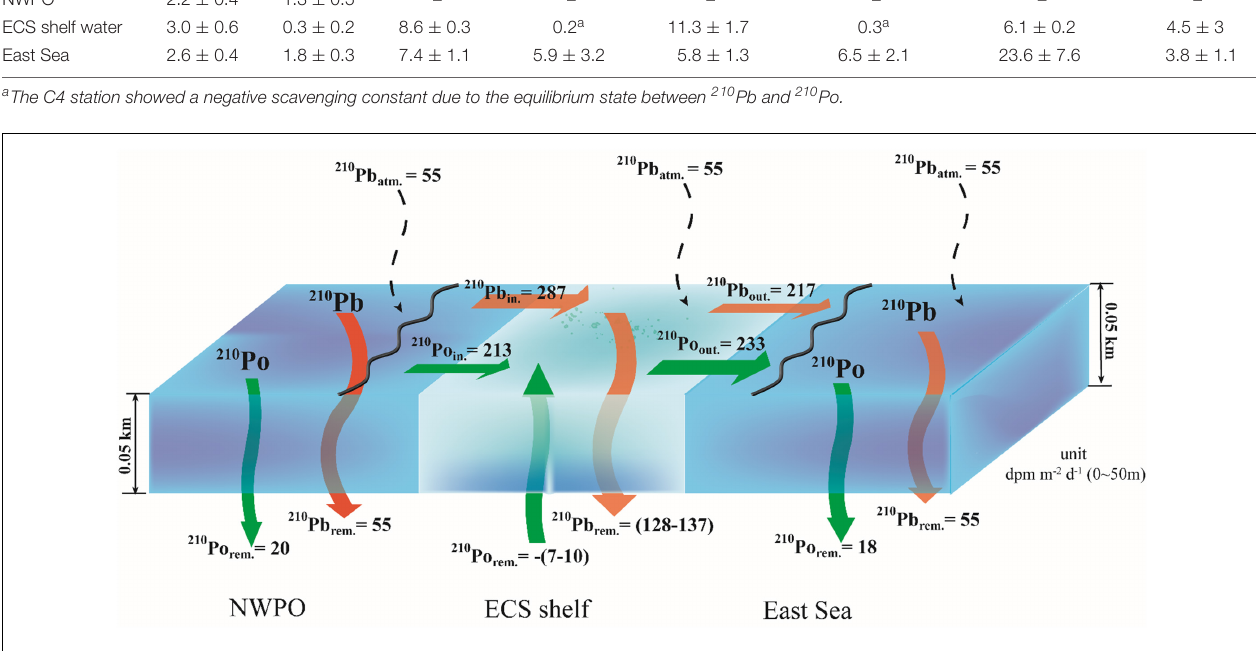
Frontiers in Marine Science |